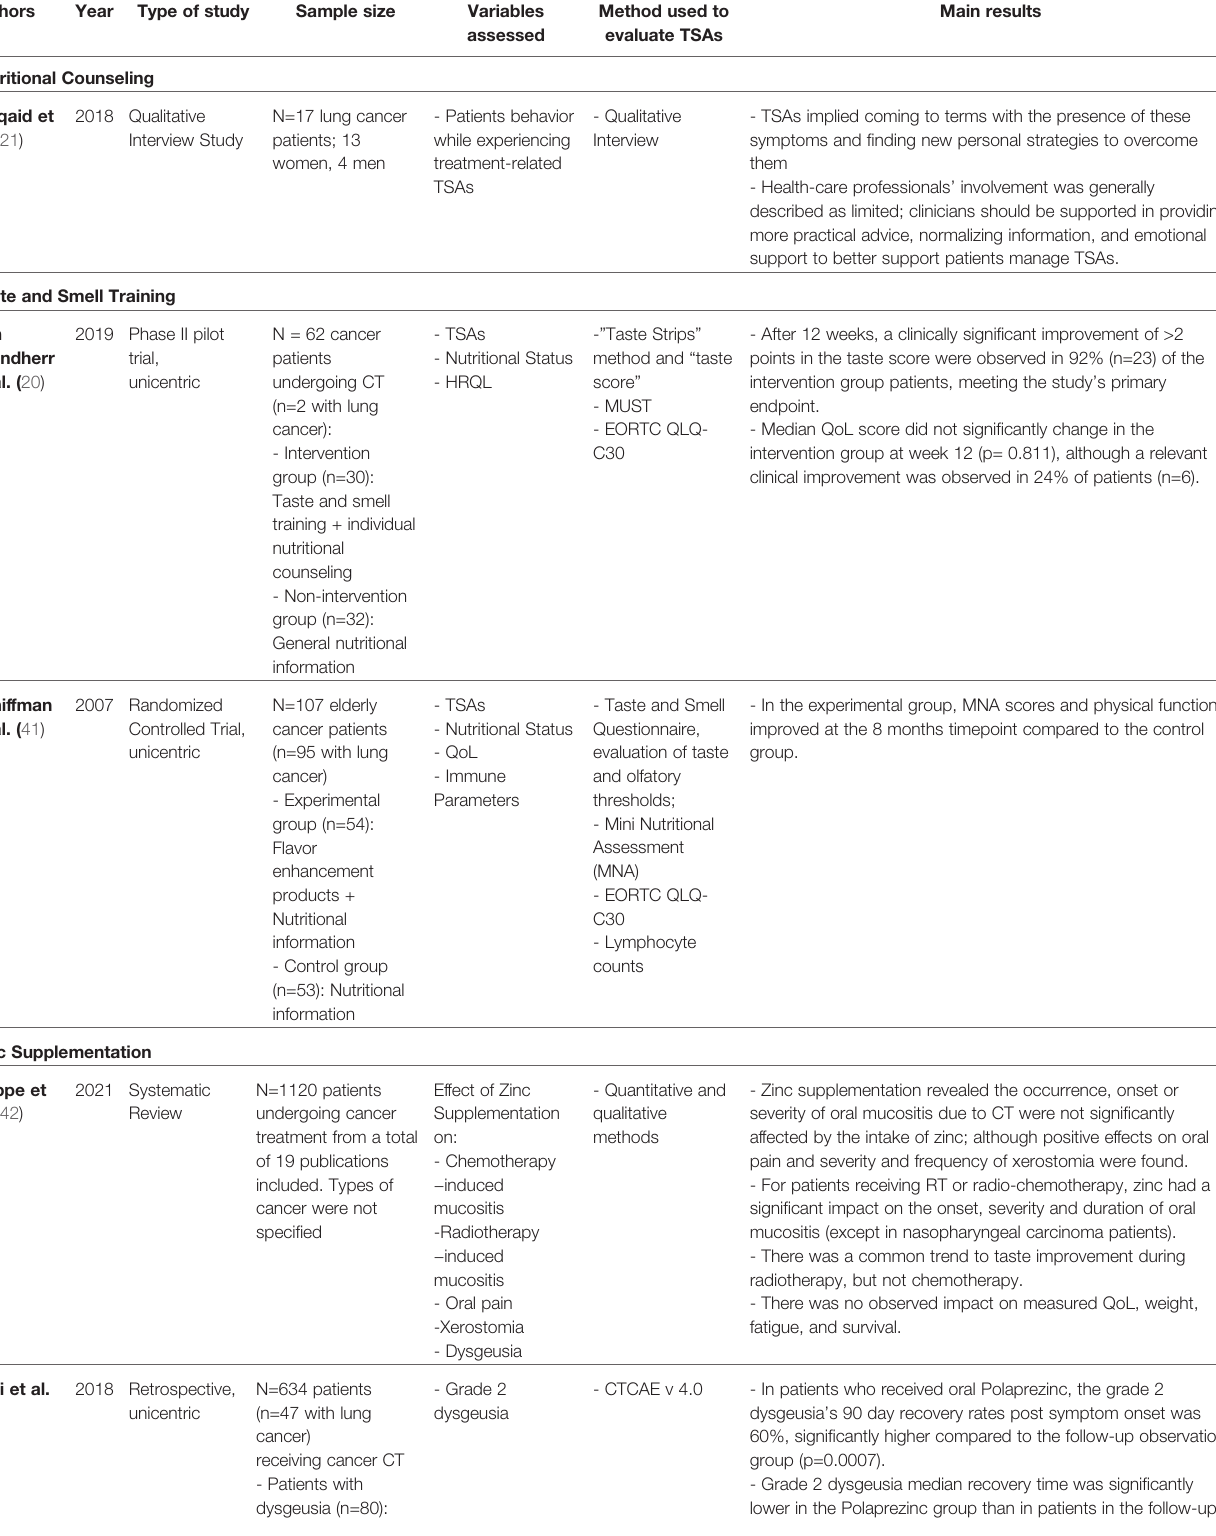
TABLE 4 | Summary of interventions to prevent or treat dysgeusia in cancer patients undergoing systemic treatment included in the